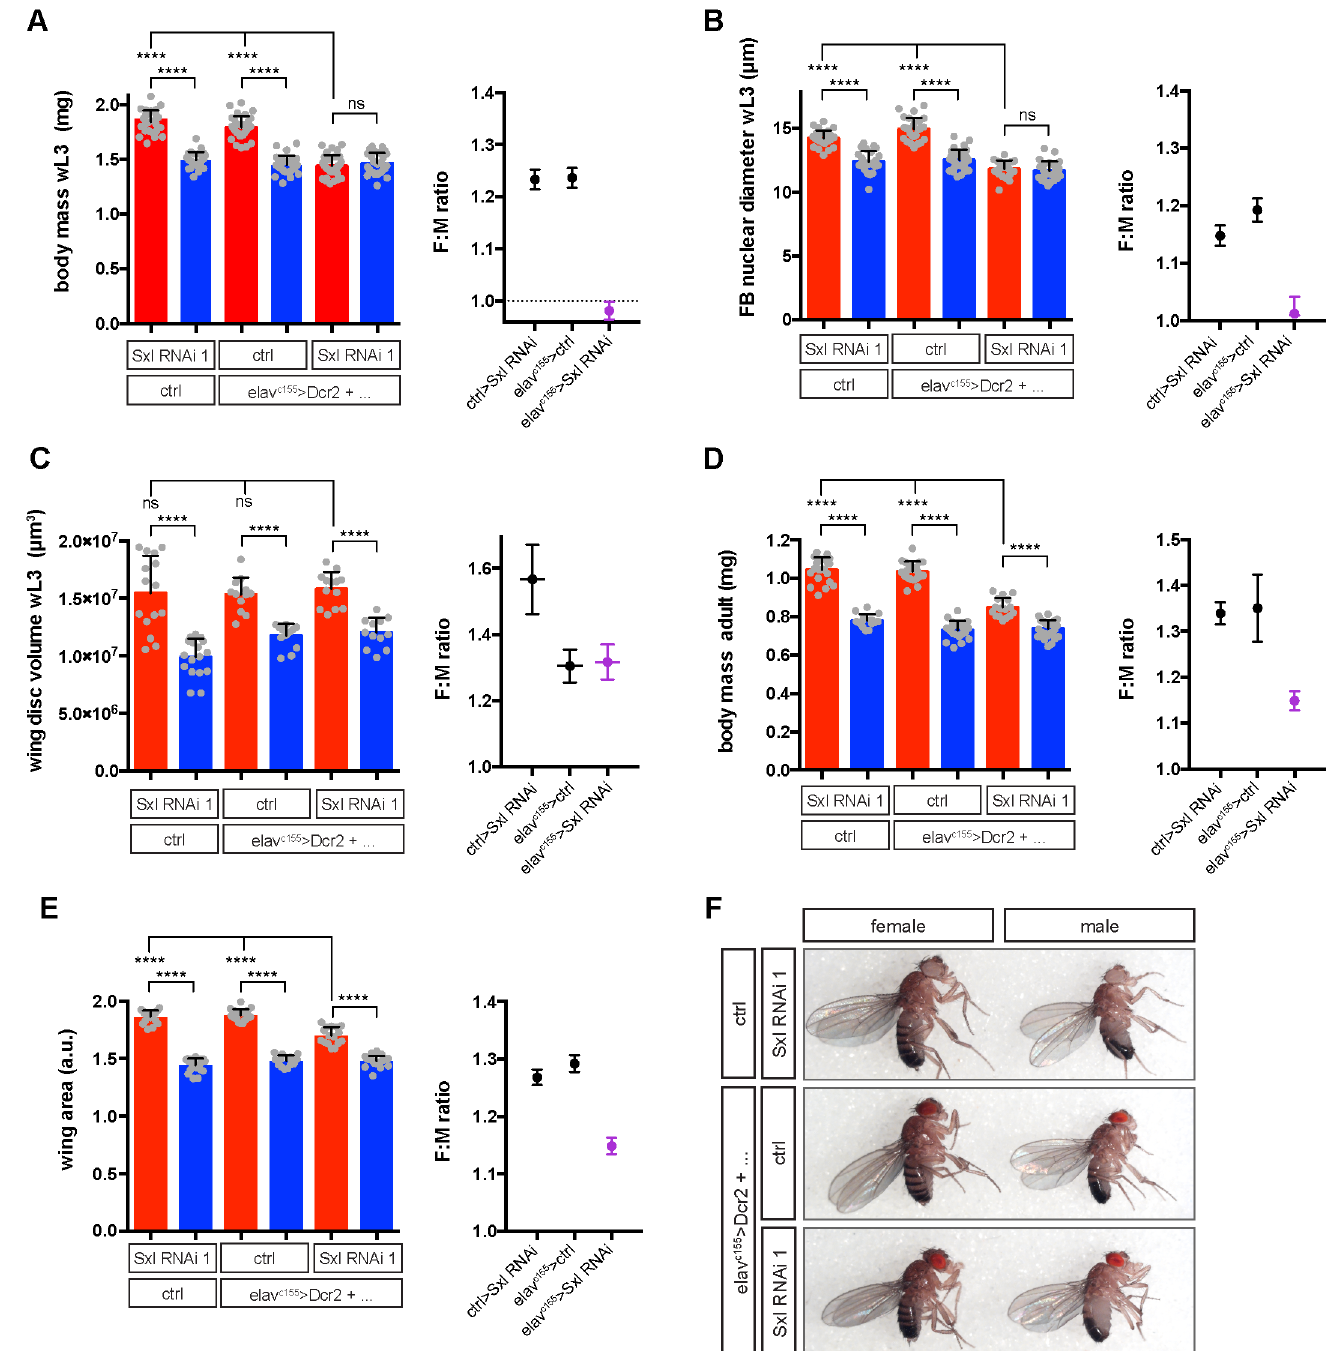
Fig 6. Neuronal Sex-lethal (Sxl) selectively controls the sexual size dimorphism (SSD) of larval versus imaginal tissues. Effect of neuron- specific depletionof Sxl ( elav c155 > Sxl RNAi 1 ) on SSD of the body and different tissues at larval and adult stages. For panels A–E, the histograms on the left show the male and female body or tissue sizes used to calculatethe female to male (F:M) ratios in the graph on the right. (A) SSD of body mass in wandering L3 larvae (wL3) is abolishedin elav c155 > Sxl RNAi animals. (B) SSD of fat body nuclei diameter(a proxy for cell size) in wL3 larvaeis abolished in elav c155 > Sxl RNAi animals. (C) SSD of wing disc volume in wL3 larvaeis not decreased in elav c155 > Sxl RNAi animals. Note that 1 of 2 control genotypes has an abnormally high F:M ratio of approximately 1.6, but this is due to a decreasein male size not to a changein female size. (D) SSD of adult body mass is decreased but not abolished in elav c155 > Sxl RNAi animals. (E) SSD of adult wing area is decreased but not abolished in elav c155 > Sxl RNAi animals. This contrasts with lack of an SSD effect in wing discs at the end of larvaldevelopment (C) . (F) Images of adult flies, showing that elav c155 > Sxl RNAi decreases female body size without alteringfemale-specific pigmentation of the abdominalcuticle. For adult body and tissue